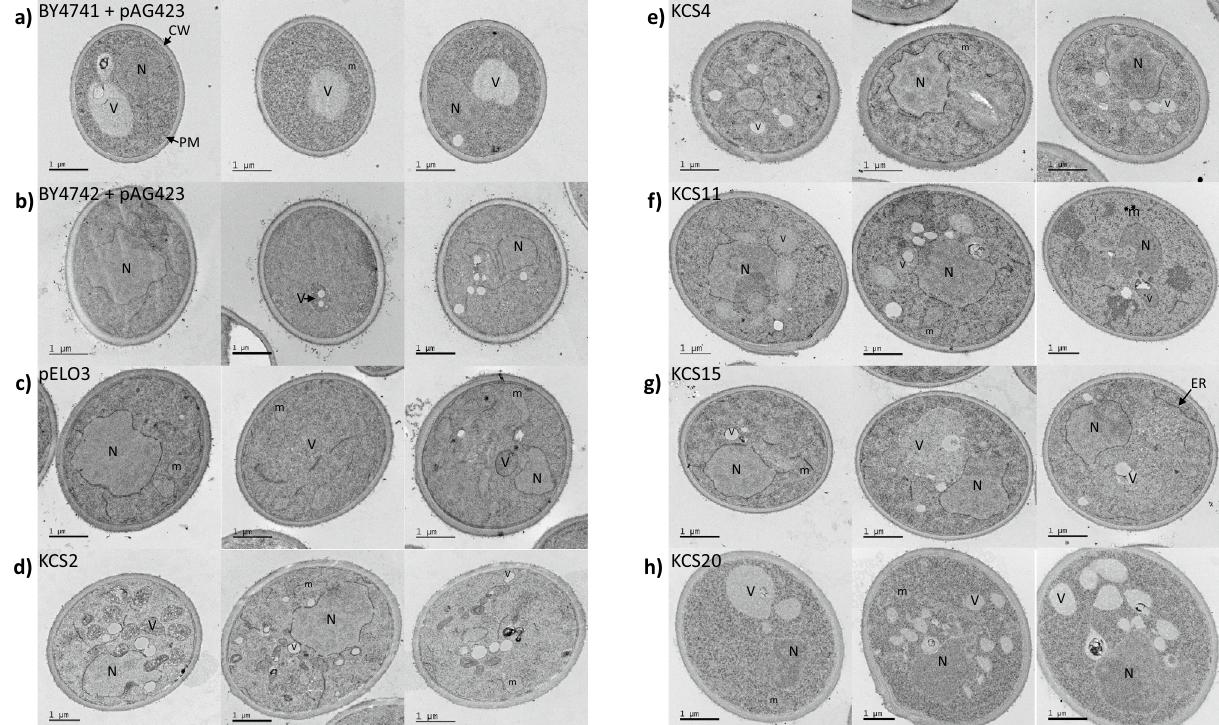
Figure 3. Ultrastructural comparison of ZmKCS complementing strains. Transition electron micrographs of three representative yeast cells of each identified genotype. V = vesicle, m = mitochondria, N = nucleus, CW = cell wall, PM = plasma membrane, ER = endoplasmic reticulum. Scale bars = 1